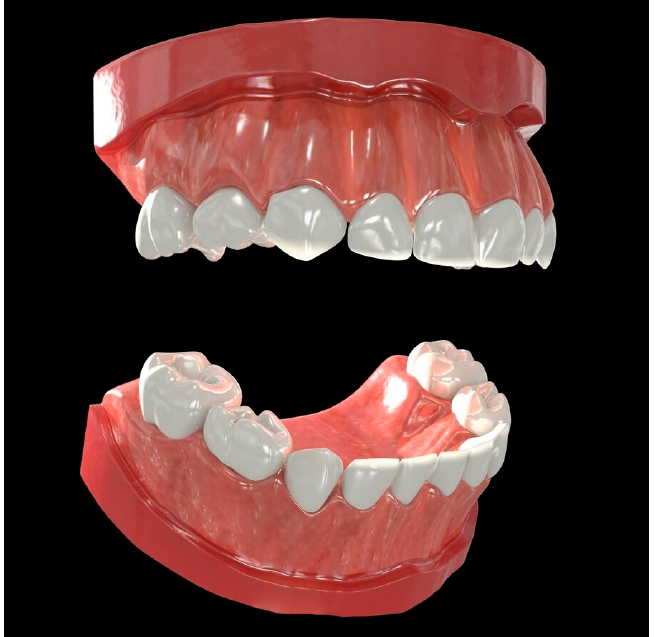
Figure 1. The original model file used in the prototype. A 3D model of the pediatric human dentition, composed of 72,597 total polygonal surfaces, and twenty-two unique textures.